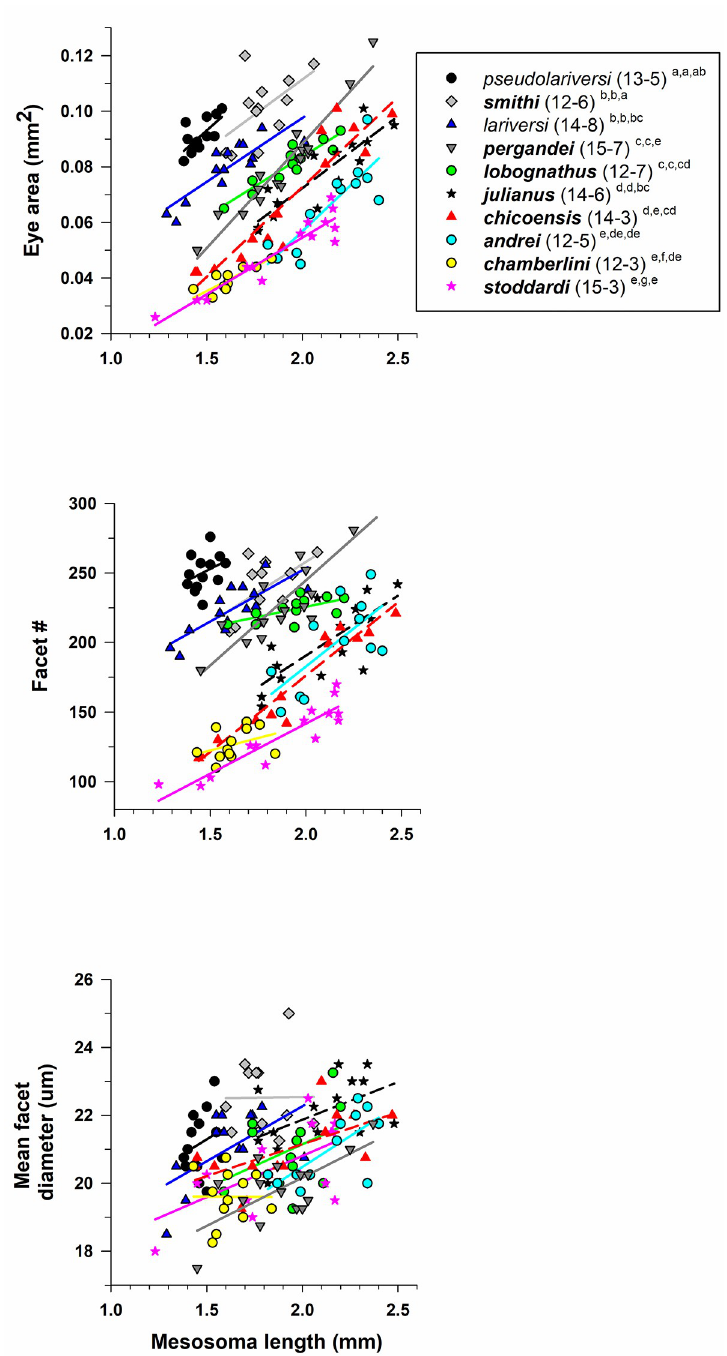
Fig 9. Eye area (mm 2 ) (A) , facet number (B) , and mean facet diameter ( D ) ( μ m) (C) for species of Veromessor (subfamily Myrmicinae: tribe Stenammini). Veromessor lariversi and V . RAJ- pseu are pale (open symbols and regular font), while the other eight species are dark (filled symbols and bold font) (see text). For each species, number of workers examined and number of colonies they derived from is given in parentheses. Significant differences ( P < 0.01) among species are denoted after each species name by the letters a–g : a > b > c > d > e > f > g ; the three sets of letters for each species correspond to panels A, B, and C, respectively. Groupings are based on univariate F tests within MANCOVA using the estimated marginal means followed by pairwise comparisons using a least significant differences test (see